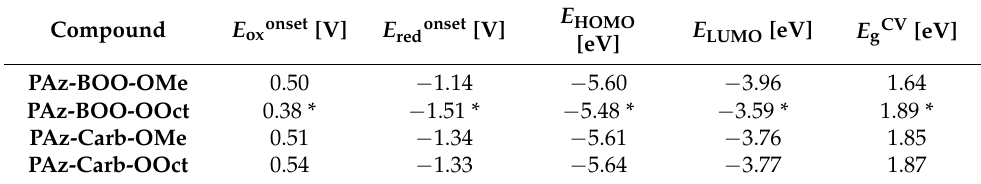
Table 4. Electrochemical properties of investigated compounds.